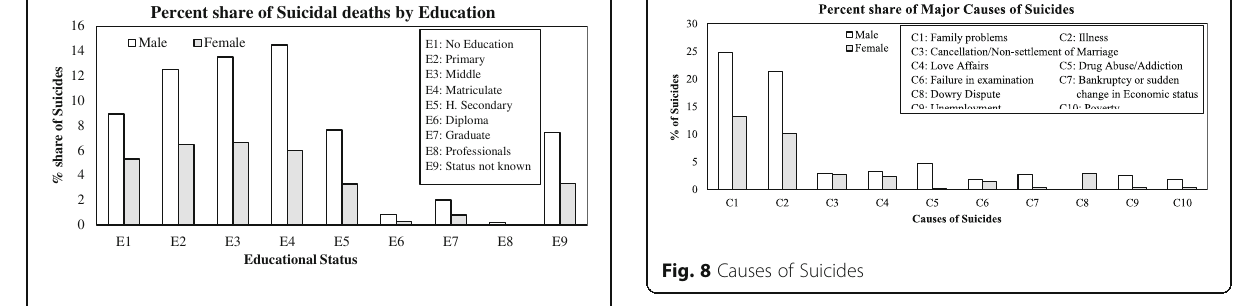
Fig. 6 Educational Status of Suicide Victims